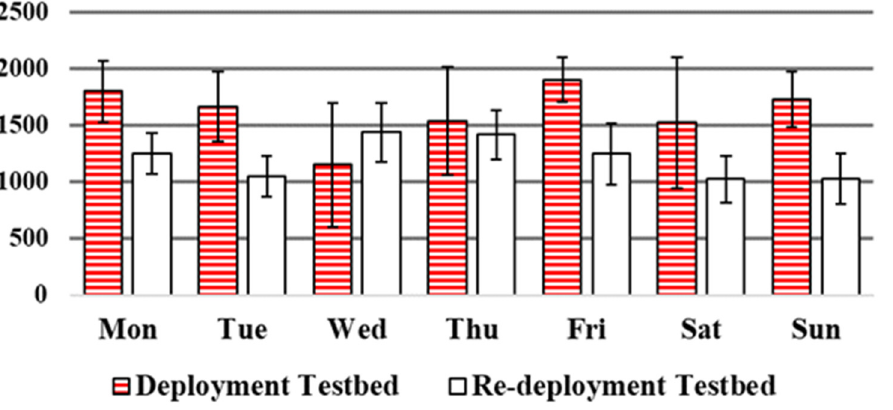
Figure 13. Average number of events. comparison between our deployment and re-deployment datasets.